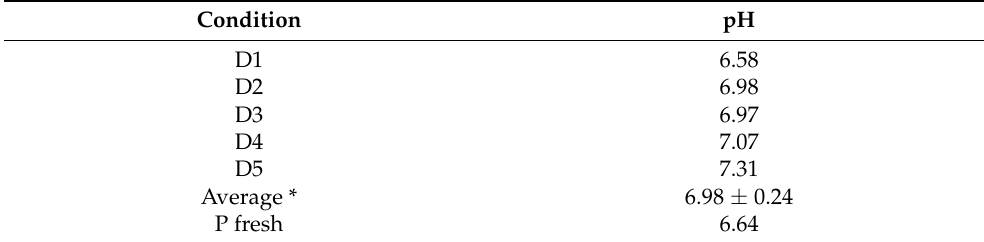
Table 4. pH Value of the Fresh Individual (D1–D5) and Pooled Fecal (P Fresh) Inoculums.